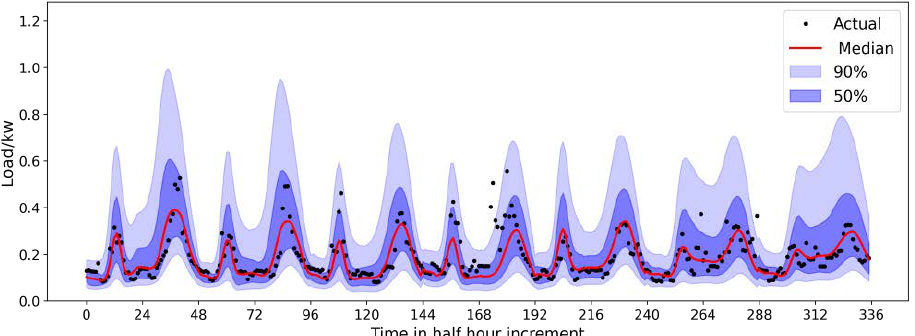
Figure 3. The quantile forecasting results of a customer in a week.